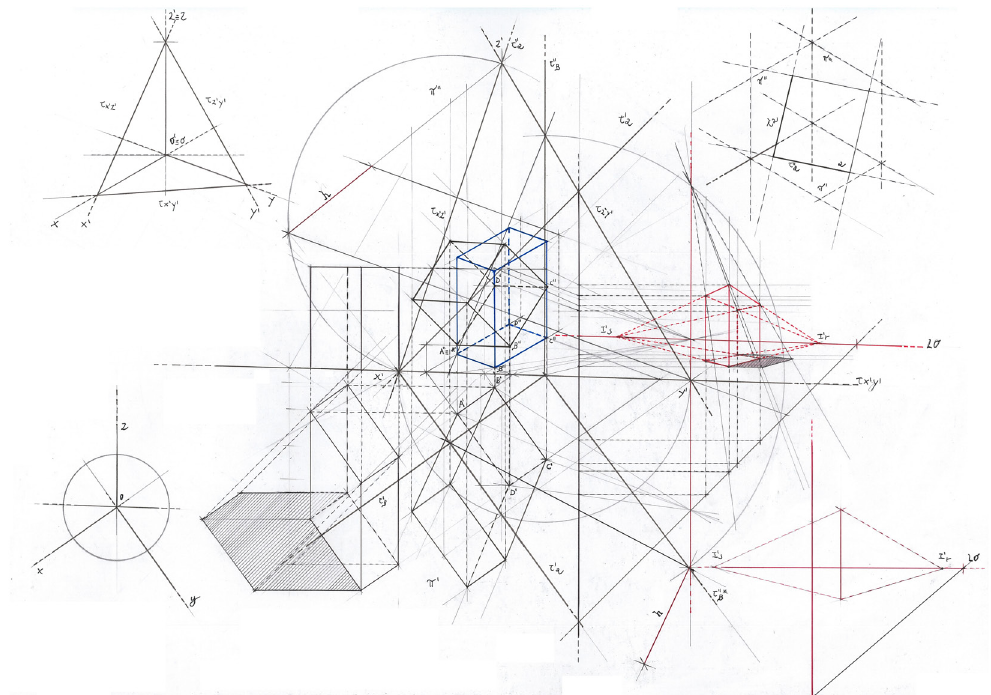
Fig. 2 Andrea Donelli, From one system to another: homological relationships between parallel projection, orthogonal projection; perspective and axonometric images , 2021, china, marker, lapis, on cardboard, 29.7x49.0 cm. Author’s